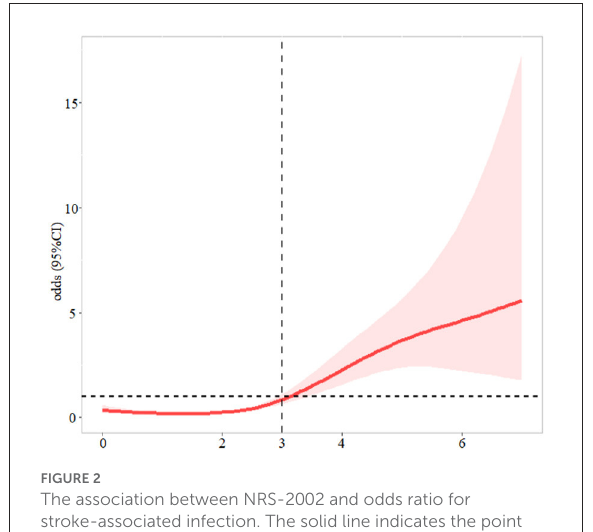
FIGURE2 The association between NRS-2002 and odds ratio for stroke-associated infection. The solid line indicates the point estimate, and the shaded area is the 95% CI. Models were adjusted by by age, sex, smoking (never, former, current), drinking (never, former, current), body mass index, systolic blood pressure, smoking, drinking,.hemoglobin, urea nitrogen, and creatinine.